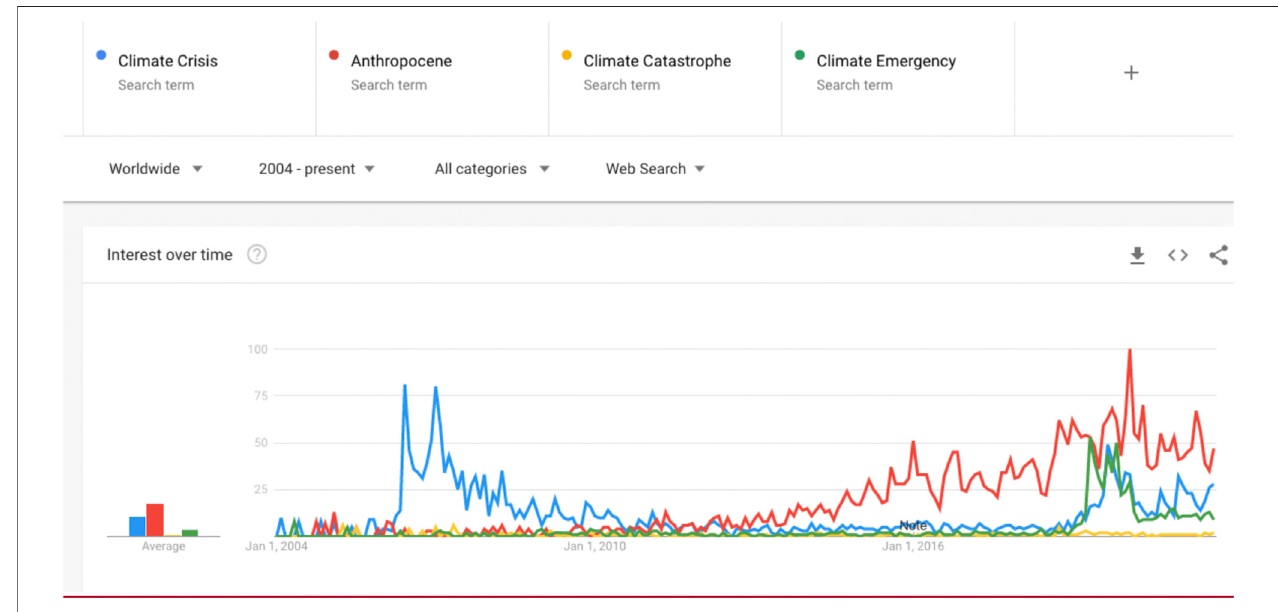
FIGURE 1 | Worldwide Google trend